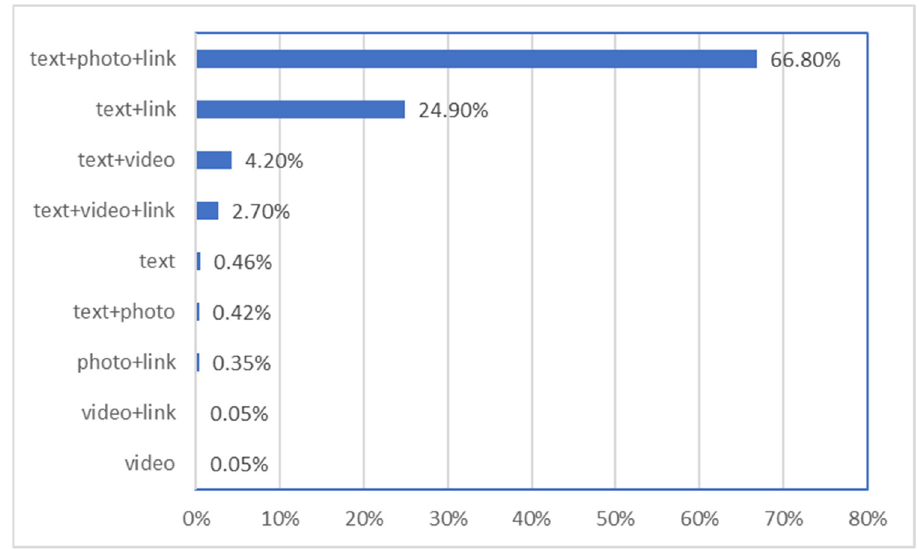
Figure 2. Post type